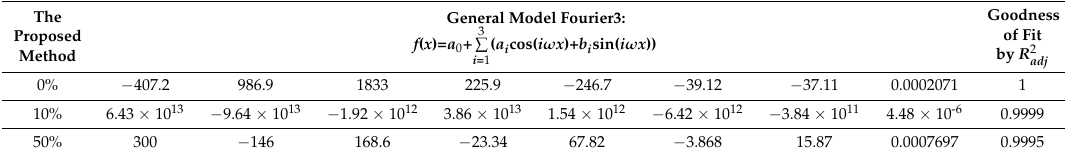
Figure 7. Comparison between the proposed method and existing model. Table 1. Fourier fitting model to data in Figure